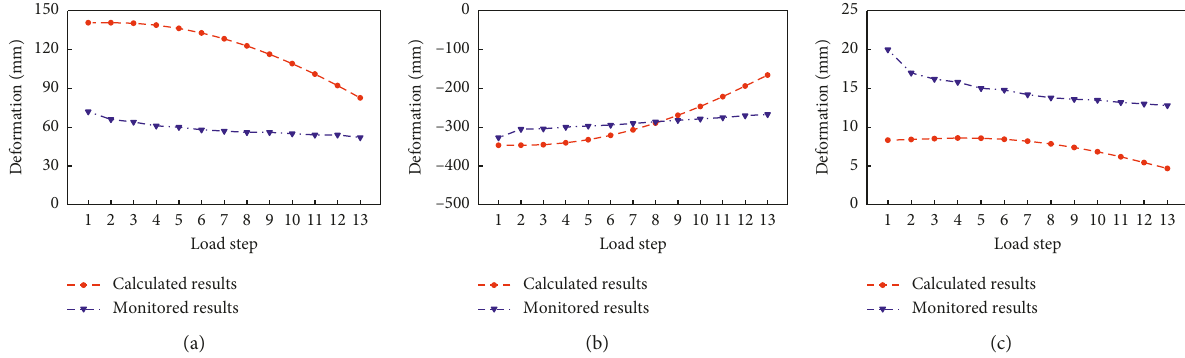
Figure 16: Comparison of calculated and monitored results of top tower deformation. (a) X direction. (b) Y direction. (c) Z direction.